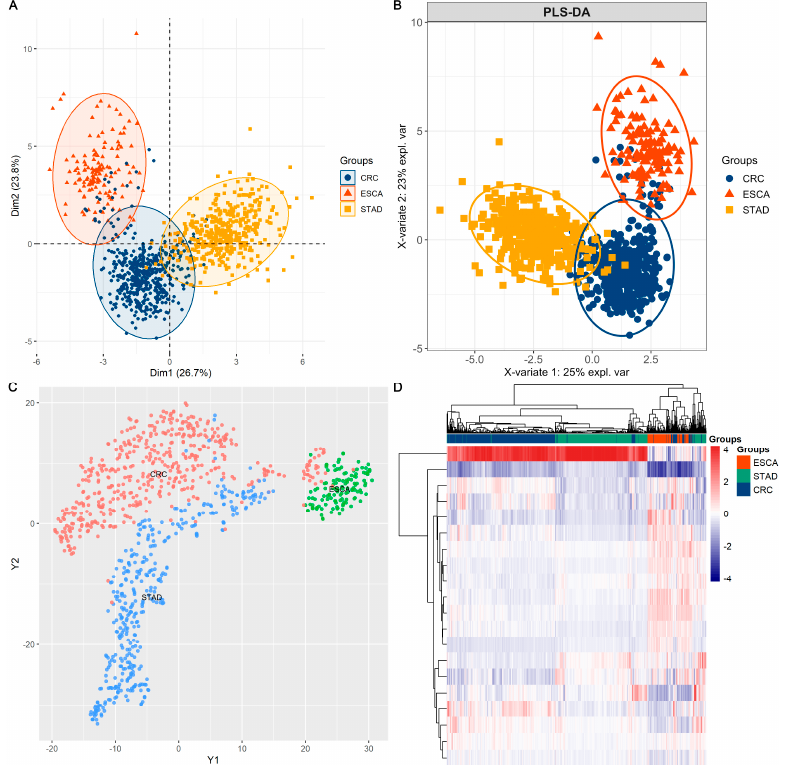
Figure 3. Clusters of tumour samples across ESCA, STAD, and CRC based on the 20 selected protein signatures: ( A ) PCA plot, ( B ) PLS-DA plot, ( C ) t-SNE, and ( D ) heatmap showing clusters of tumour samples in ESCA, STAD, and CRC.